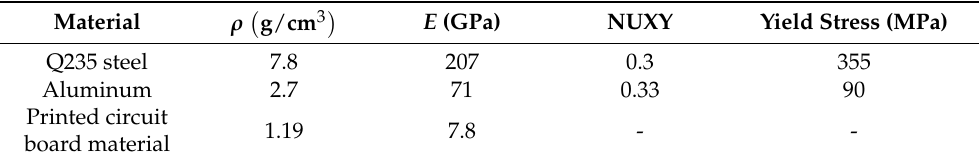
Table 4. Material parameters for the simulation cabin.